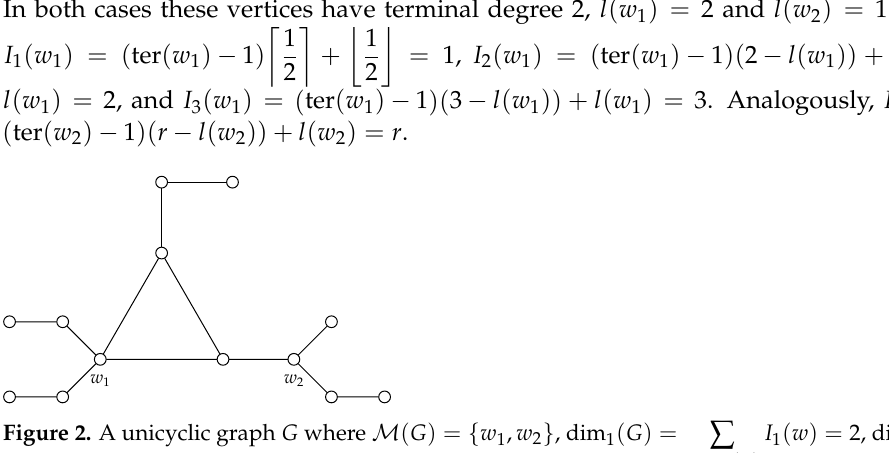
Figure 2. A unicyclic graph G where M ( G ) = { w 1 , w 2 } , dim 1 ( G ) =